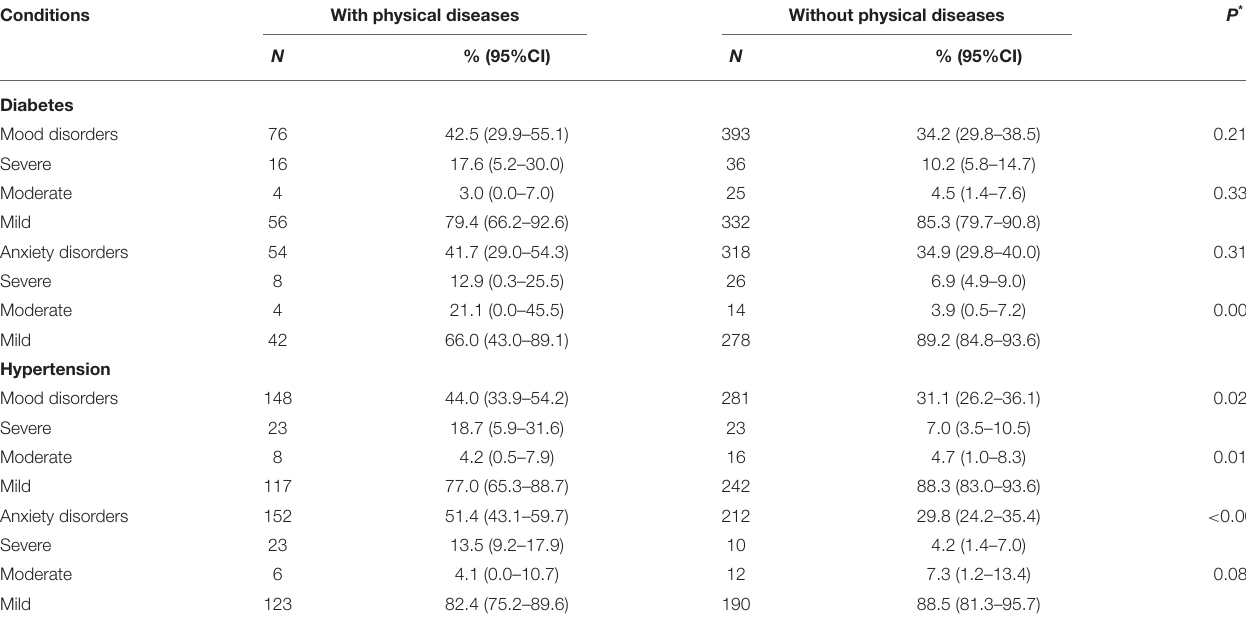
TABLE 3 | Comparison of the weighted disability and the severity of disability across the status of physical diseases. Conditions With physical diseases Without physical